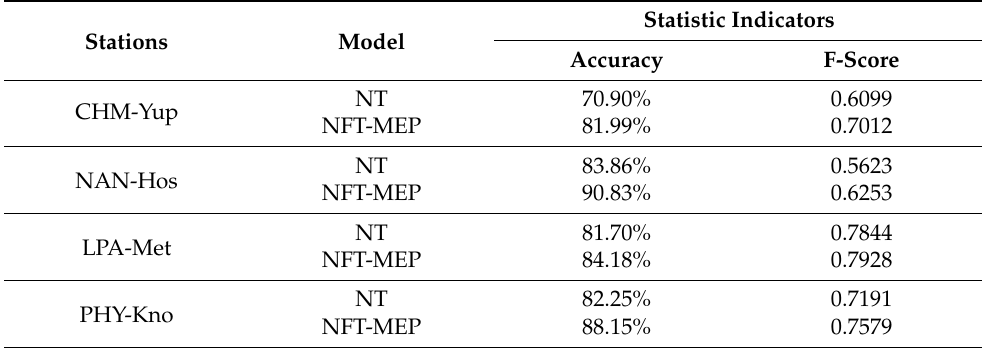
Table 5. Comparison result between the NT and NFT-MEP models to predict hourly PM 10 with three classes of output